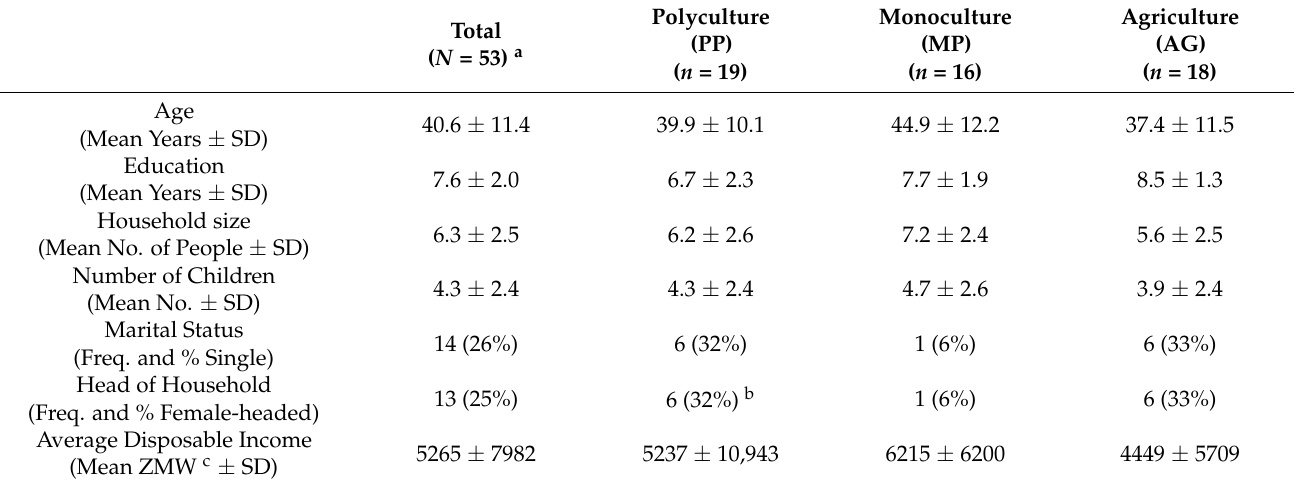
Table 2. Household descriptive